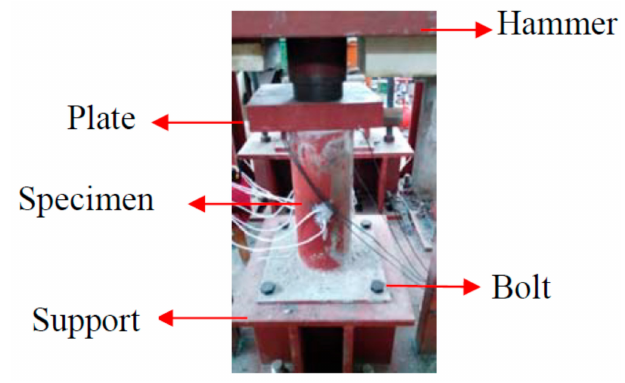
Figure 6. Experimental